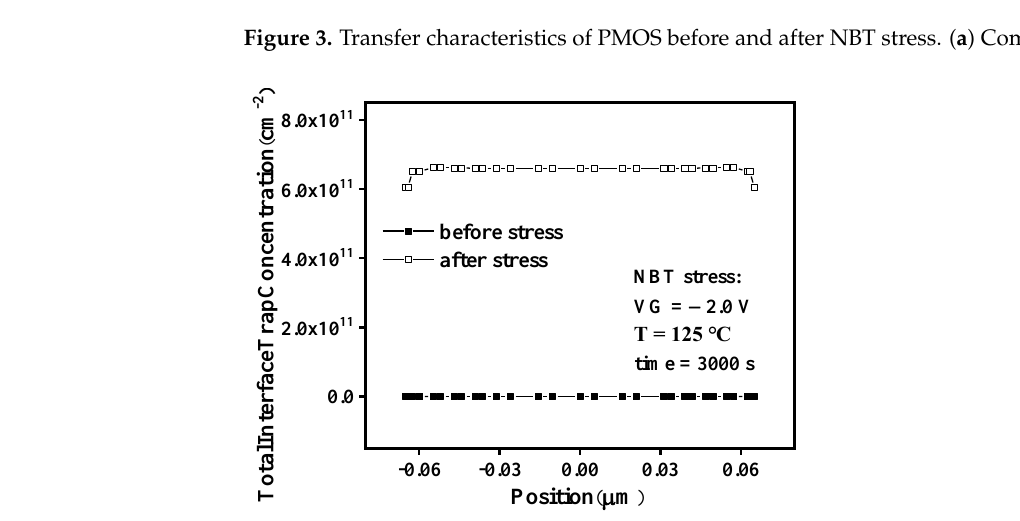
Figure 3. Transfer characteristics of PMOS before and after NBT stress. ( a ) Complete, ( b ) Enlarged.